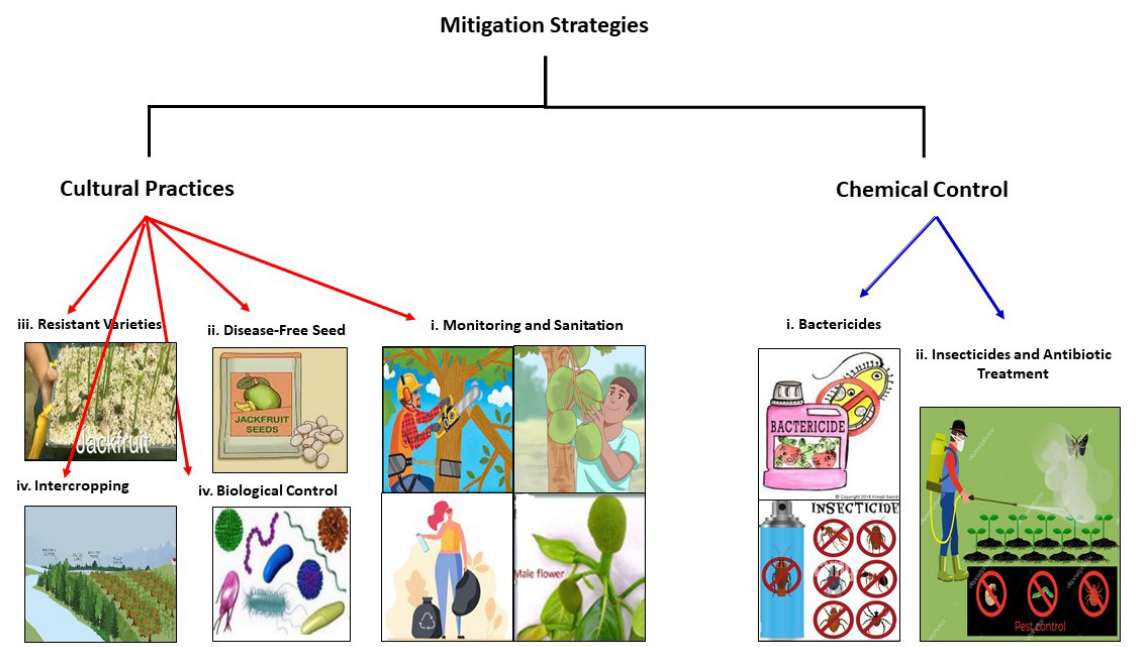
Figure 10. Potential mitigation strategies of jackfruit-bronzing disease. Cultural practices include monitoring and sanitation, disease-free seed, resistant varieties, biological control, and intercrop- ping (red arrows). Chemical control includes bactericides, insecticides, and antibiotic treatment (blue arrows).